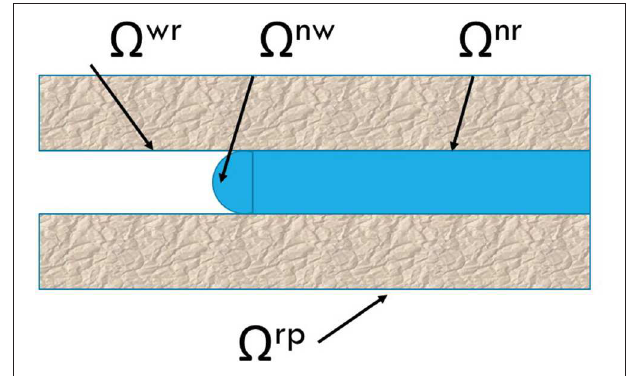
FIGURE 2 | Illustration of contact areas between the phases. A cylindrical pore is chosen as